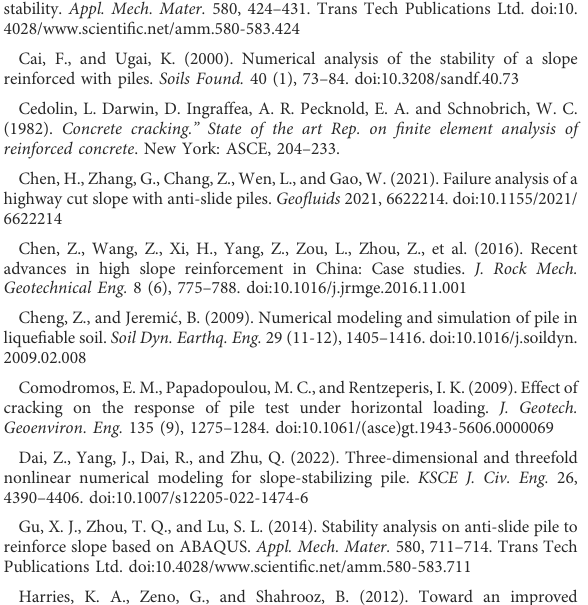
shaking table test. Soil Dyn. Earthq. Eng. 115, 352 – 364. doi:10.1016/j.